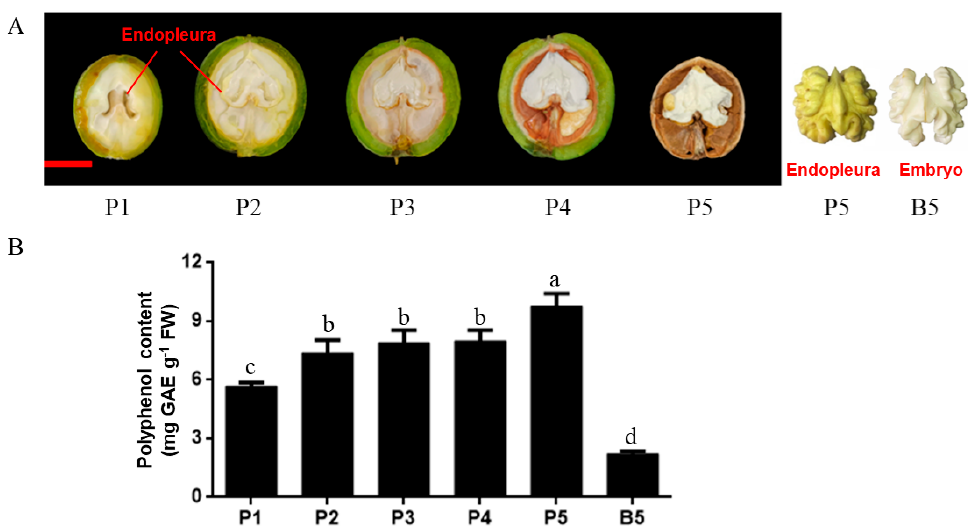
Figure 1. Morphological characteristics and polyphenol contents in the developing endopleura and mature embryo. ( A ) The image with black background shows the longitudinal section of the walnut fruits when the endopleura was sampled. Fruits were collected at 35, 63, 91, 119, and 147 DAP. The image with white background shows the endopleura and embryo at mature stage. The ruler is 2 cm. ( B ) Polyphenol contents in the developing endopleura and mature embryo. Values are means ± standard deviation (SD), n = 3. Same letters stand for insignificance at p ≥ 0.05 by one ‐ way ANOVA.